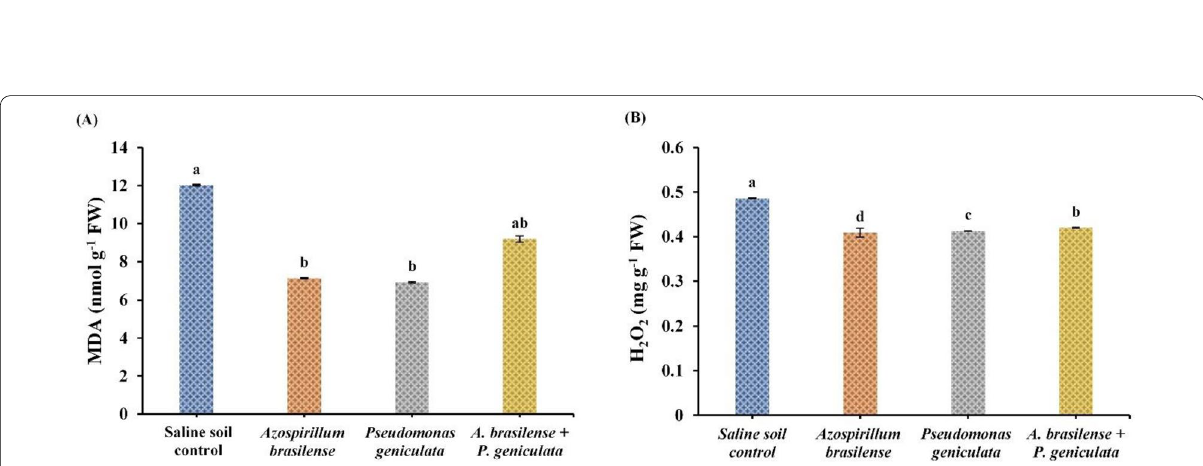
Fig. 5 Effect of the inoculation with Azospirillum brasilense , Pseudomonas geniculata individually or co-inoculation on ( A ) MDA (nmol g − 1 FW); ( B ) H 2 O 2 (mg g − 1 FW) contents of flax plants ( Linum usitatissimum ) grown in saline soil. Bars represent the mean of three replicates (n indicate standard error. Different letters indicate significant difference among means according to LSD test at p < 0.05. FW fresh weight ±